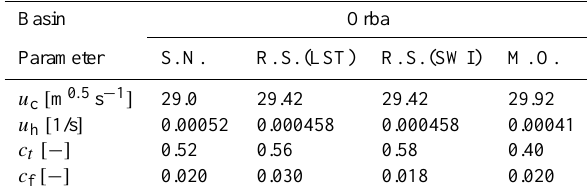
Figure 8. The Orba basin, August–September 2006. Example of a two by two sensitivity analysis: sub-surface parameters, c t versus c f . On x and y axis the values of the two parameters are reported while on z axis the parameter likelihood is shown. Table 5. The Orba basin parameters were calibrated following the different approaches: using the multi-objective function (M. O.), remote-sensing data and morphologic characteristics (R. S.), and the standard hydrographs comparison (S. N.). The table reports the values obtained by the 4 different calibration